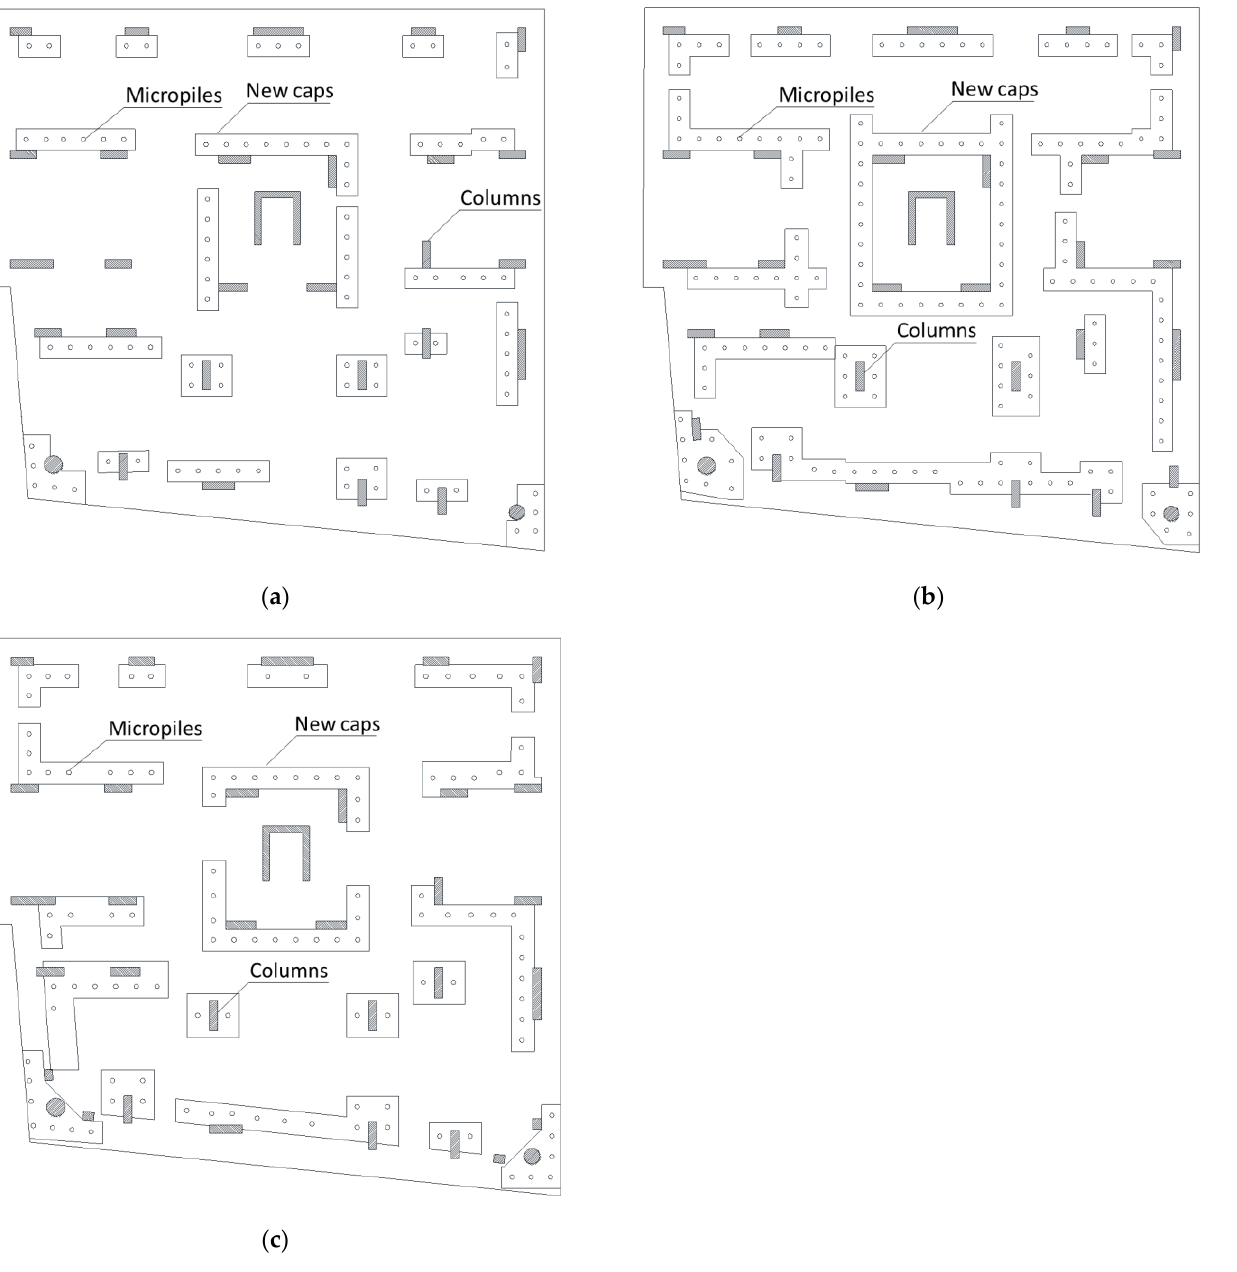
Figure 6. Layouts of the three proposed micropile configurations: ( a ) first approach, ( b ) second approach, and ( c ) third approach. approach, and ( c ) third